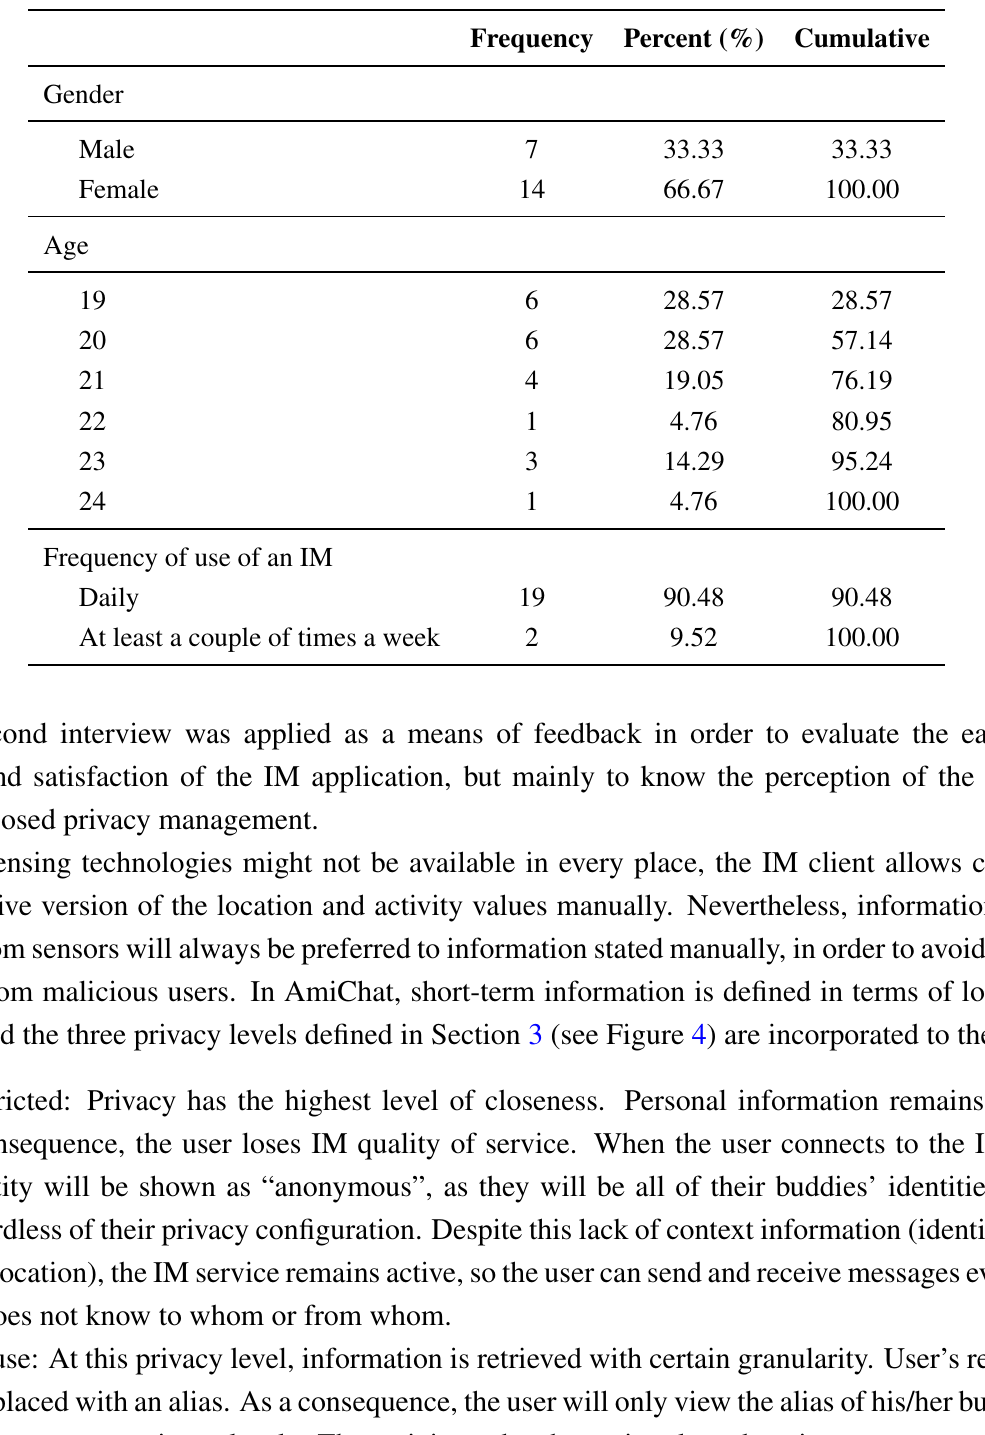
Table 2. Demographic attributes of the